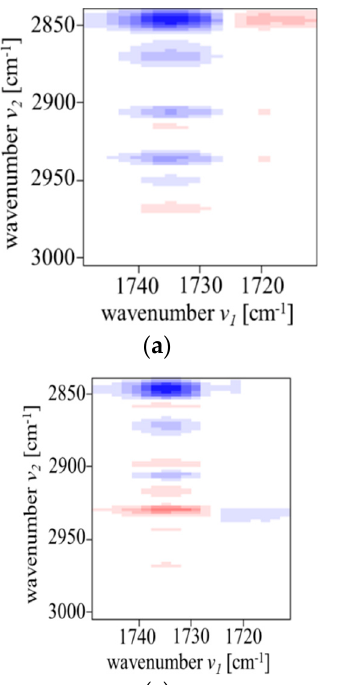
cm –1 and ( b , d ) 1750–1710 cm –1 vs. 1400–1000 cm –1 . The red or blue areas represent positive or and ( b , d ) 1750–1710 cm − 1 vs. 1400–1000 cm − 1 . The red or blue areas represent positive or negative